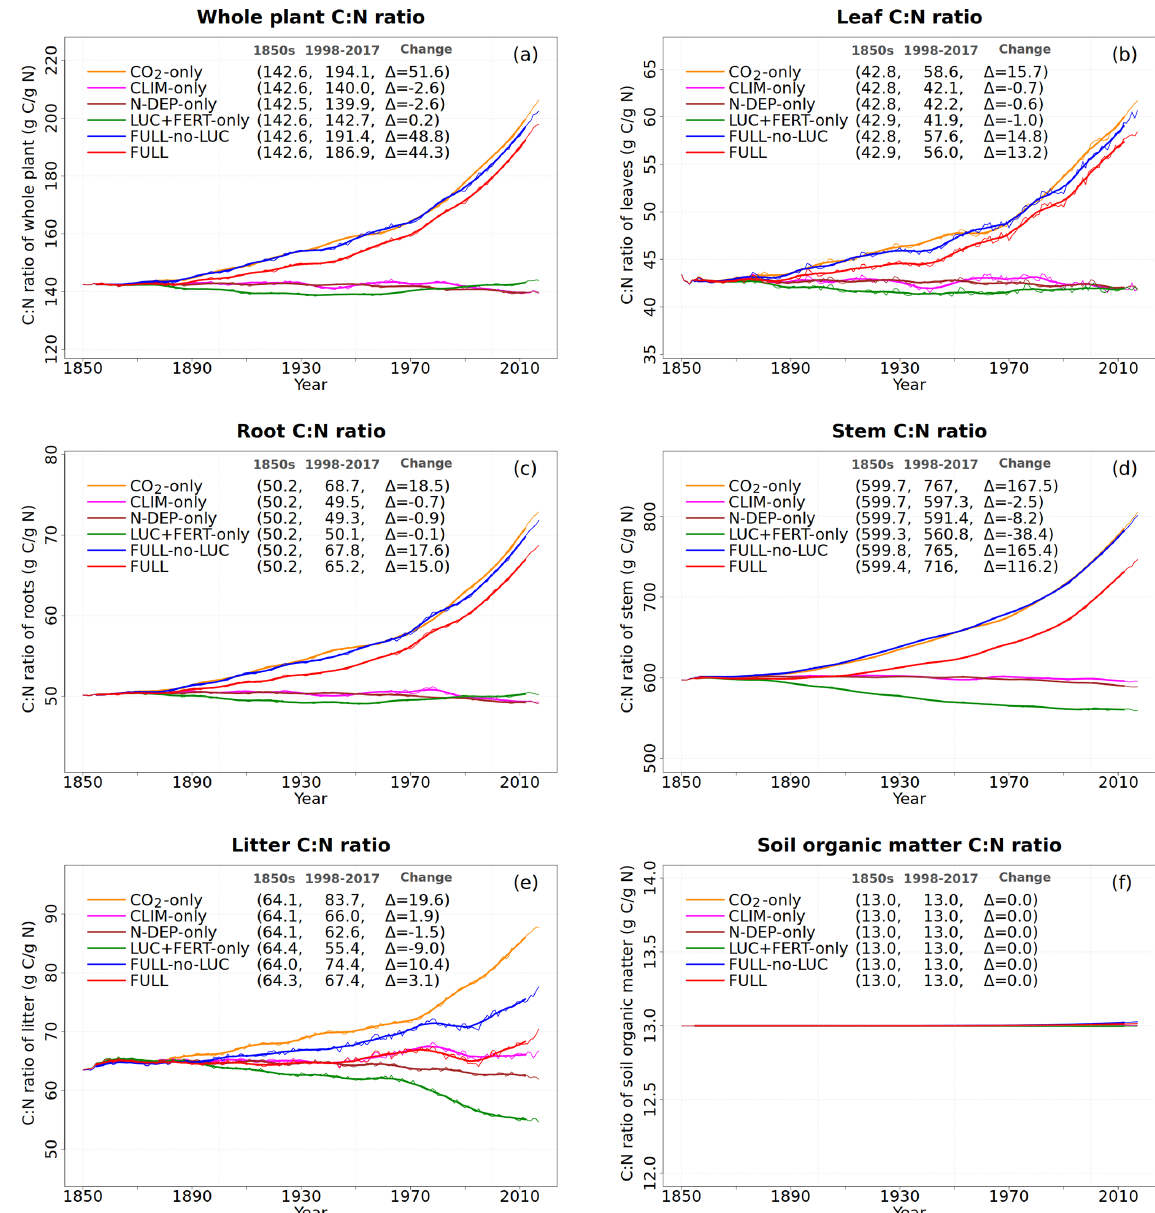
Figure 7. Global annual values of C : N ratios for whole plant (a) , leaves (b) , root (c) , stem (d) , litter (e) , and soil organic matter (f) pools from the primary six simulations. The values in the parentheses for legend entries show the average for the 1850s, the average for the 1998–2017 period, and the change between them. The thin lines show the annual values, and the thick lines show their 10-year moving